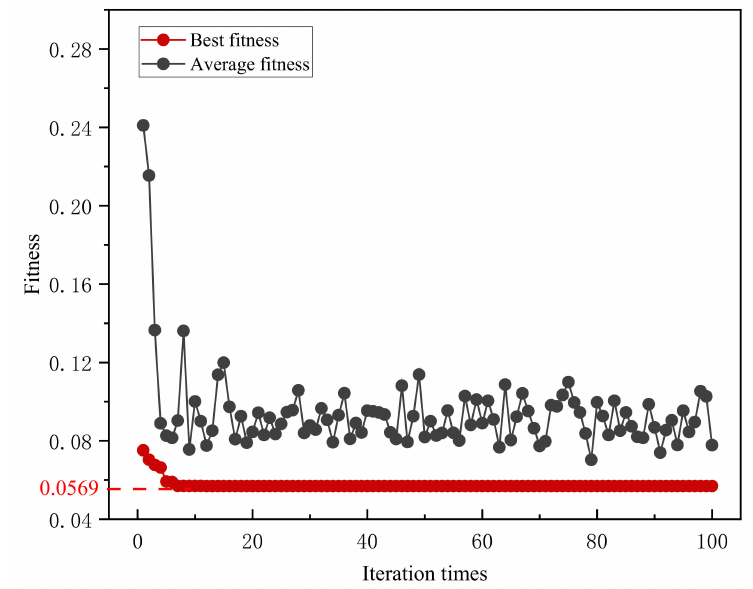
Figure 16. Fitness value of the SSA-SVR model.